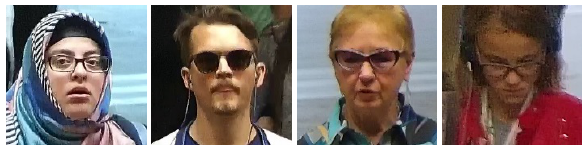
Figure 1. CAS-Peal Sample